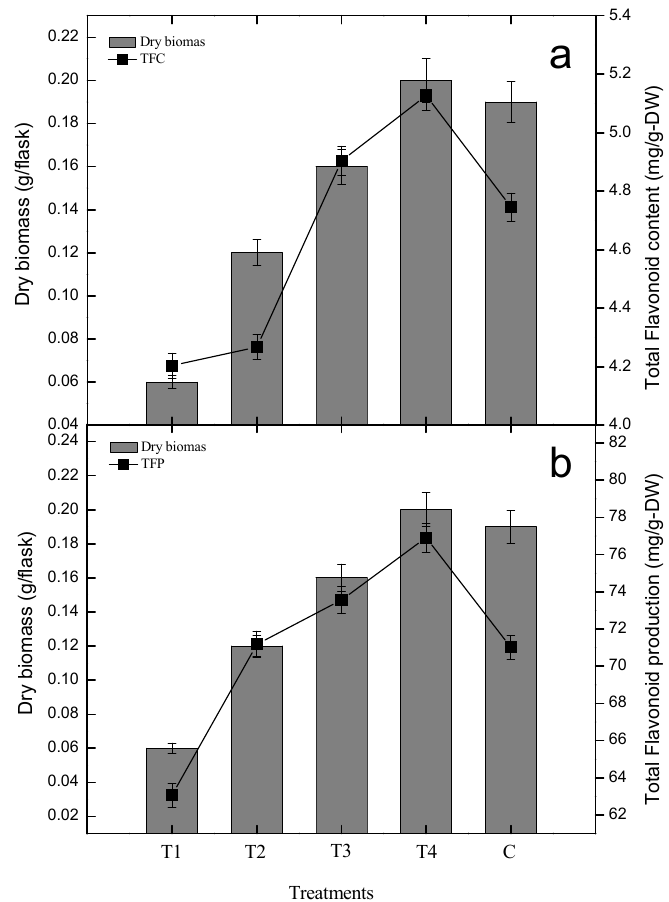
Figure 3. Biomass and PGRs show dependent linear and positive correlation with flavonoids biosynthesis ( a ) and flavonoids production ( b ) in S. rebaudiana adventitious root cultures in vitro. The triplicate data in the mean along with standard errors (SE) are significantly different at p < 0.05.